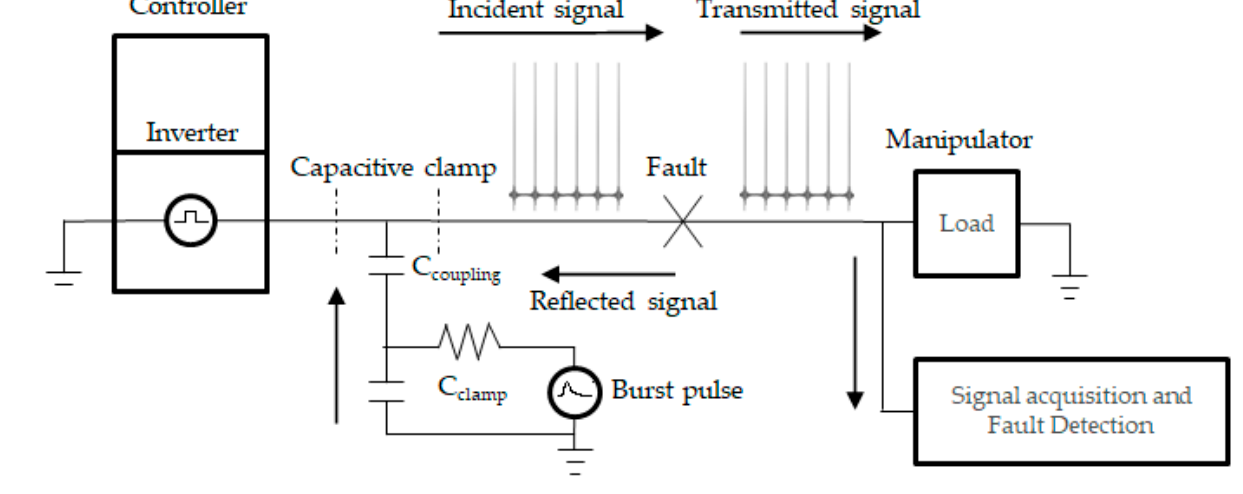
Figure 9. PBI cable fault diagnosis.